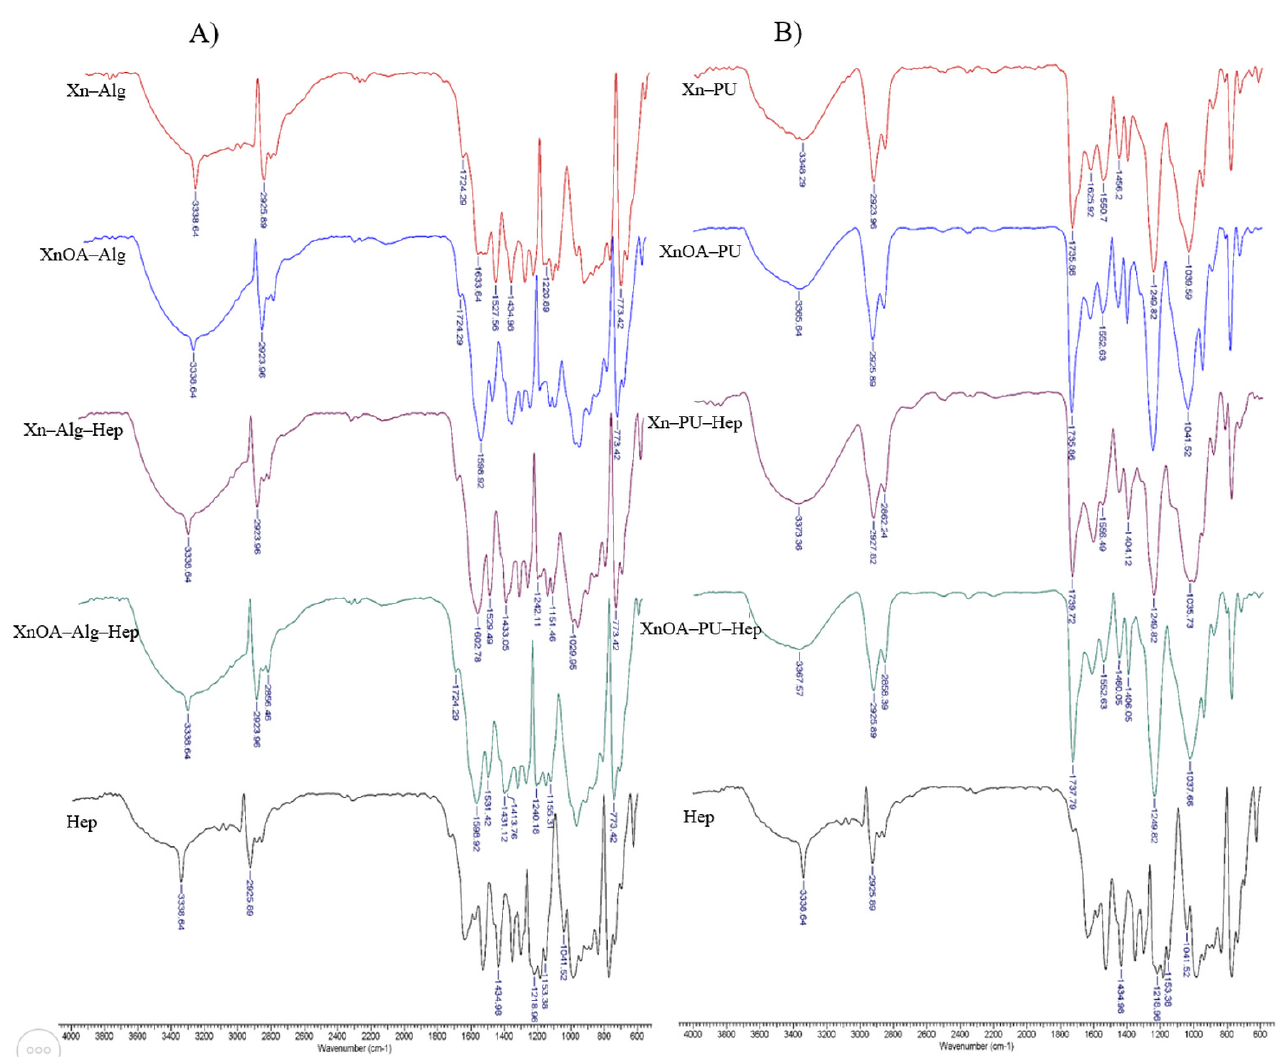
Figure 1. FTIR spectra of the materials (( A )—materials based on Xn–Alg matrix; ( B )—materials based on Xn–PU matrix).